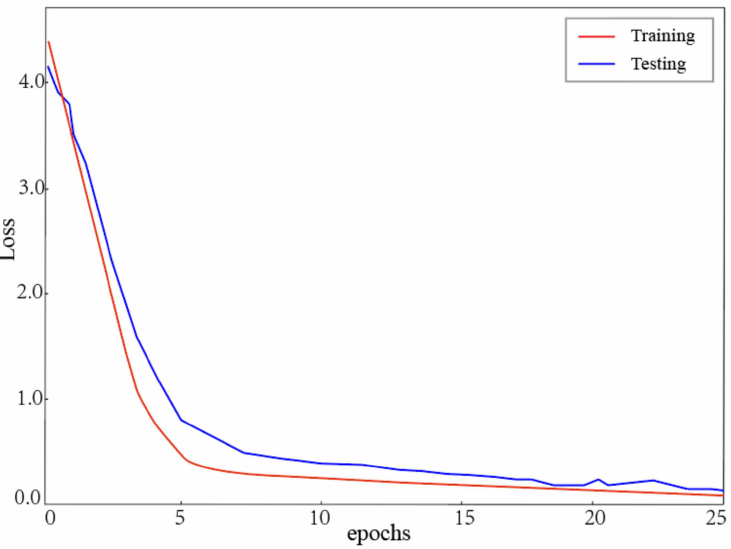
Figure 8. Training and test loss of TSM-ResNet50 depending on the